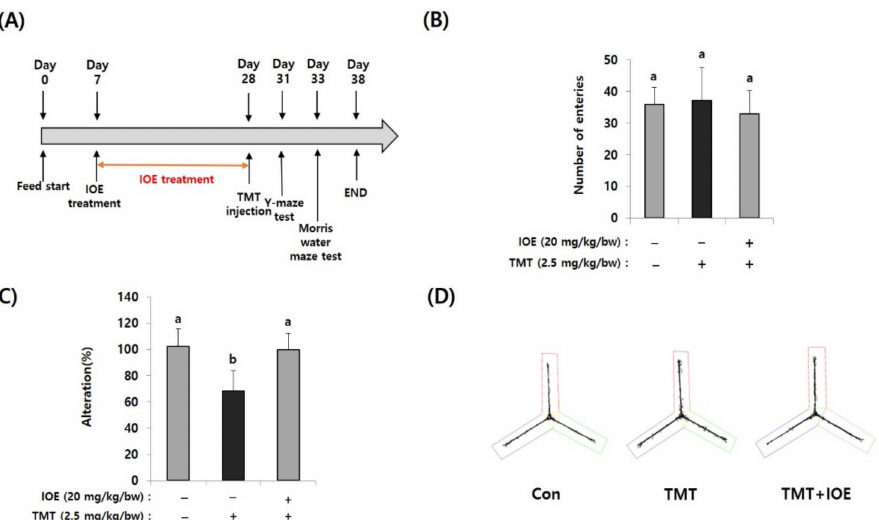
Figure 1. Oral administration of Ishige okamurae extract (IOE) attenuated the trimethyltin (TMT)- mediated spatial memory impairment in mice. After oral administration of IOE to mice (male, C57BL/6), TMT was intraperitoneally injected to mice ( n = 5) ( A ). Memory impairment was investi- gated by the Y-maze test. The number of entries was not different among groups ( B ) but TMT-induced spontaneous alteration (%) was restored in IOE mice compared with that in TMT mice group ( C ). Path tracing of each group ( D ). Data shown are means ± SD. Con: control (non-treated), a: significant differences ( p < 0.05) when compared with